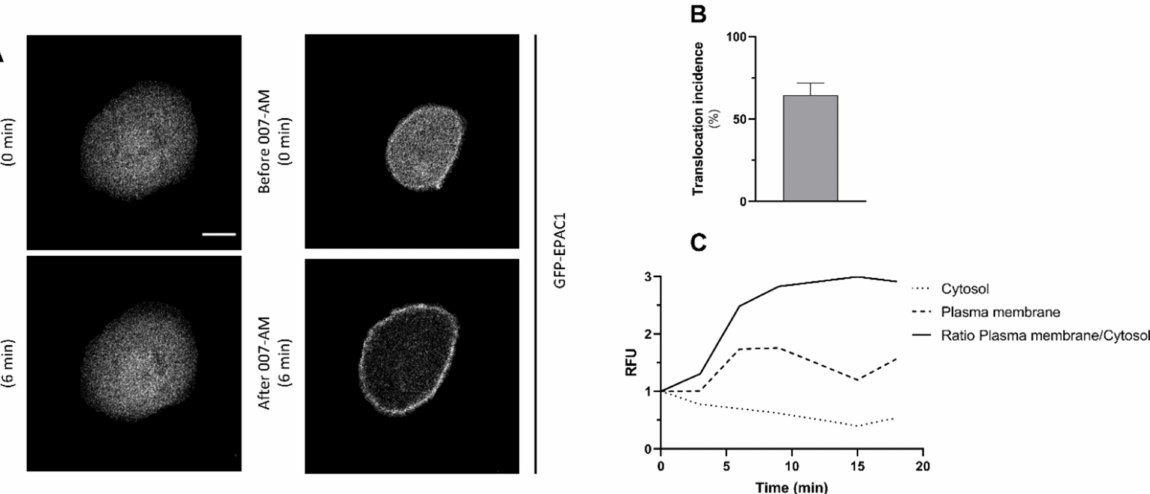
Figure 1. EPAC1 translocation after treatment with 007-AM in CFBE cells. ( A ) Localization of GFP- EPAC1 was determined by confocal live-cell imaging in CFBE wt-CFTR cells. Panels display detection of EPAC1 before (upper panels) and 6 min after (lower panels) addition of 1 µ M 007-AM (right panels) or DMSO (left panels). Scale bars: 10 µ m. ( B ) Quantification of the fraction of cells that display EPAC1 translocation to the PM after 007-AM stimulation (counting was carried out as described [9]; n = 3, 10–15 cells per experiment). ( C ) Representative intensity of pixel fluorescence (relative fluorescence units, RFU) of GFP–EPAC1 at the PM versus in the cytoplasm during stimulation with 1 µ M 007-AM relative to pre-stimulus levels in CFBE wt-CFTR cells. Image acquisition was performed every 3 min and 007-AM stimulation was initiated at 3